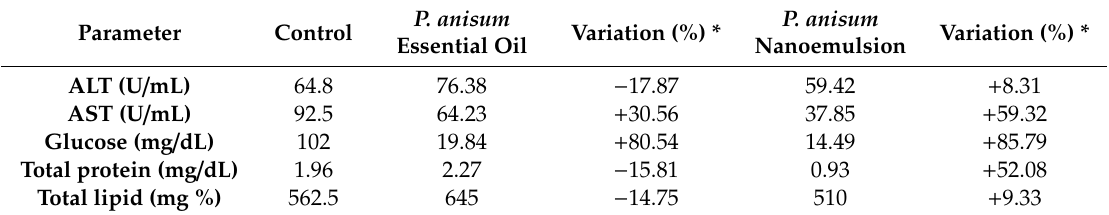
Table 3. Effect of 4 day-treatment with LC 50 of Pimpinella anisum essential oil and nanoemulsion on ALT and AST enzymes and major biochemical parameters in Tribolium castaneum beetles.